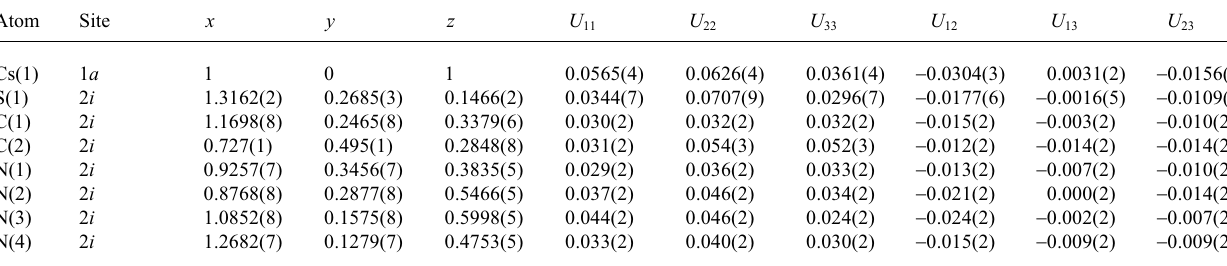
Table 3. Atomic coordinates and displacement parameters (in Å 2 ) .